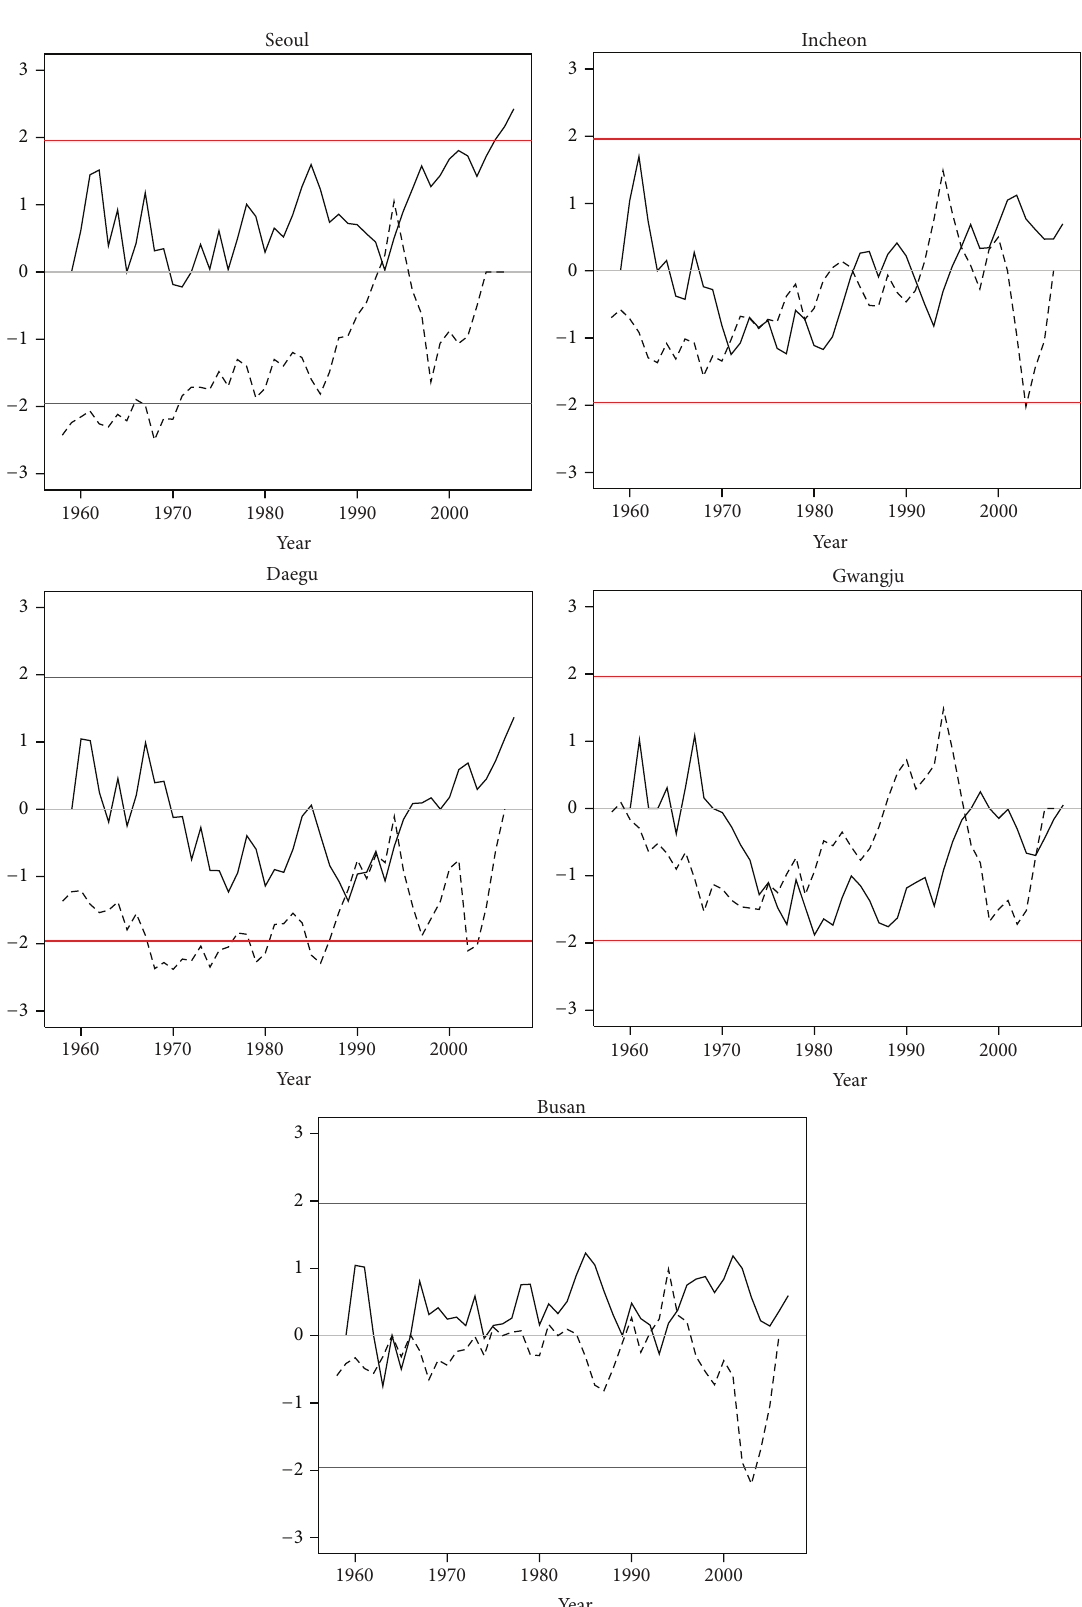
Figure 3: Sequential Mann-Kendall statistic values of forward sequence (solid line), backward sequence (dashed line), and confidence limit at 5% (red line) for time